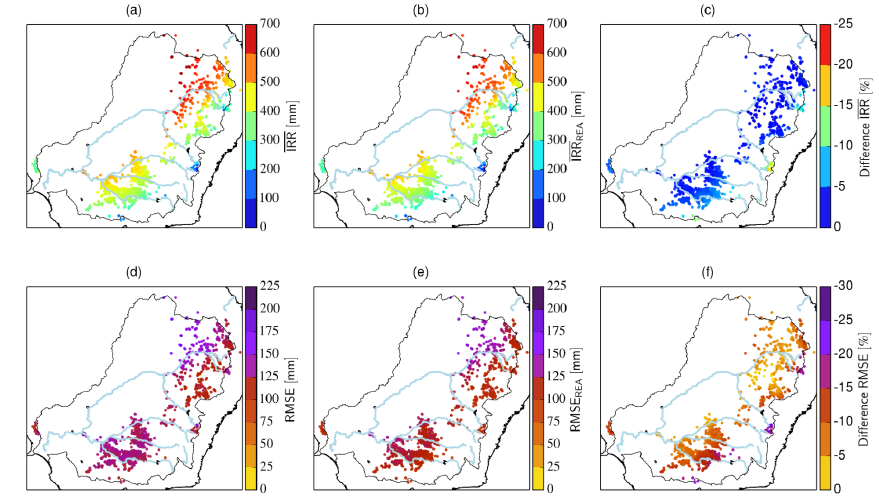
Figure 5. Average equally weighted (a) and REA-weighted (b) irrigation water requirement during the growing season of wheat (1986– 2006). Dots indicate irrigated cropping areas ( n = 3969; cell size = 1 × 1km) (note: a buffer has been used to increase the visibility of the single grid cells). (c) illustrates the difference between both IRR calculations (b – a) . (d and e) show the root mean square error between the 30 realizations and the equally weighted (d) and REA-weighted (e) averages as well as the difference (f) between both calculations,